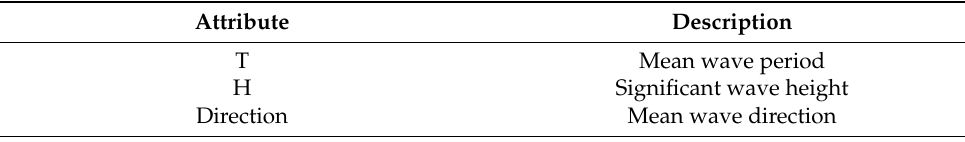
Table 3. WHM attribute table.